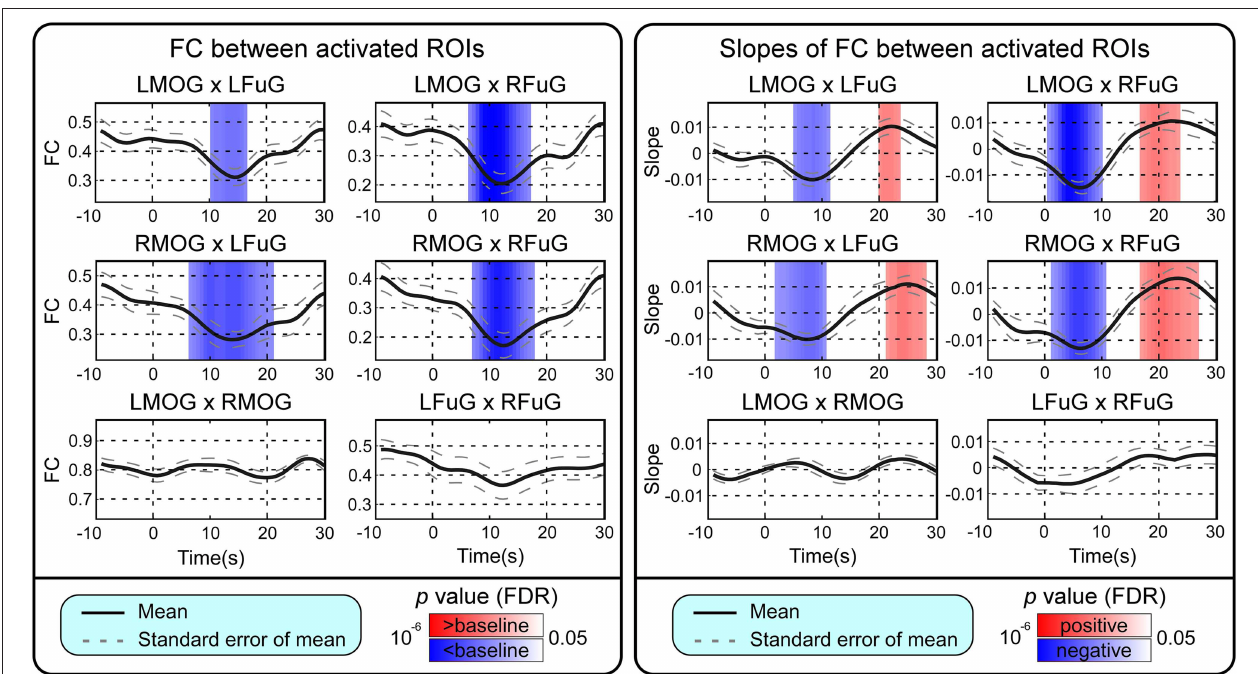
FIGURE 3 | Left: Mean and standard error of mean (SEM) of FCs between four activated ROIs. Two-tailed t -test was used to examine whether the FC after stimulus onset was larger or smaller than that in baseline at each time point. The time points with significantly larger or smaller ( p < 0.05 , FDR corrected) FC than that in baseline were highlighted with red or blue background, respectively. Right : Mean and SEM of slopes of FCs between four activated ROIs. Two-tailed t -test was used to examine whether the slope of FC was larger than 0 or smaller than 0 at each time point. The time points with significantly positive or negative ( p < 0.05 , FDR corrected) slope values were highlighted with red or blue background, respectively. Stimulation period was from 0 to 20s. Results were averaged across three blocks and all